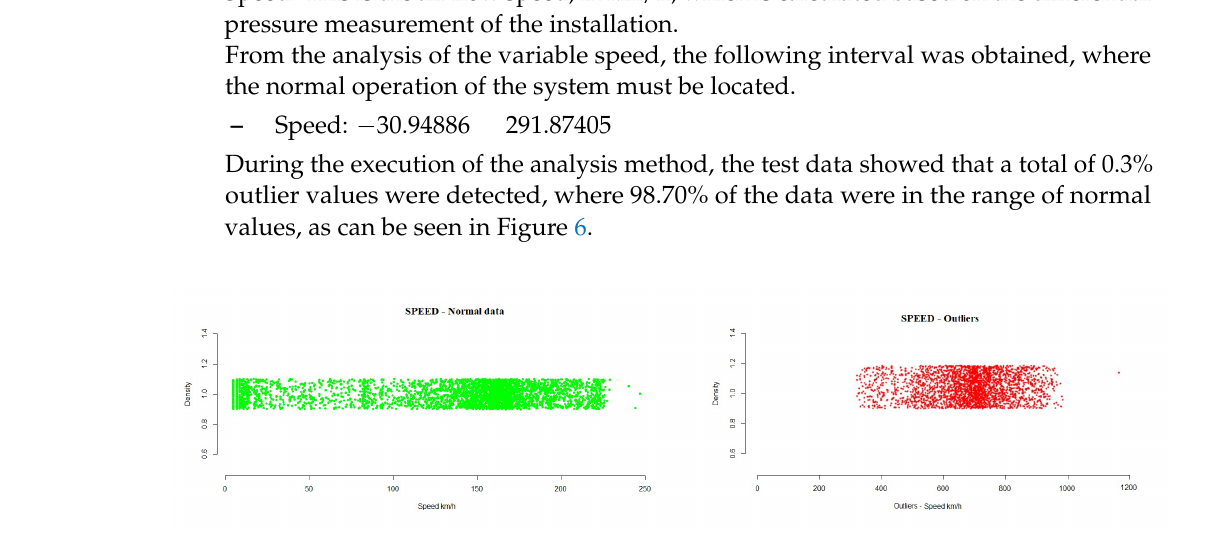
Figure 6. Example of speed outliers detected in the testing data.